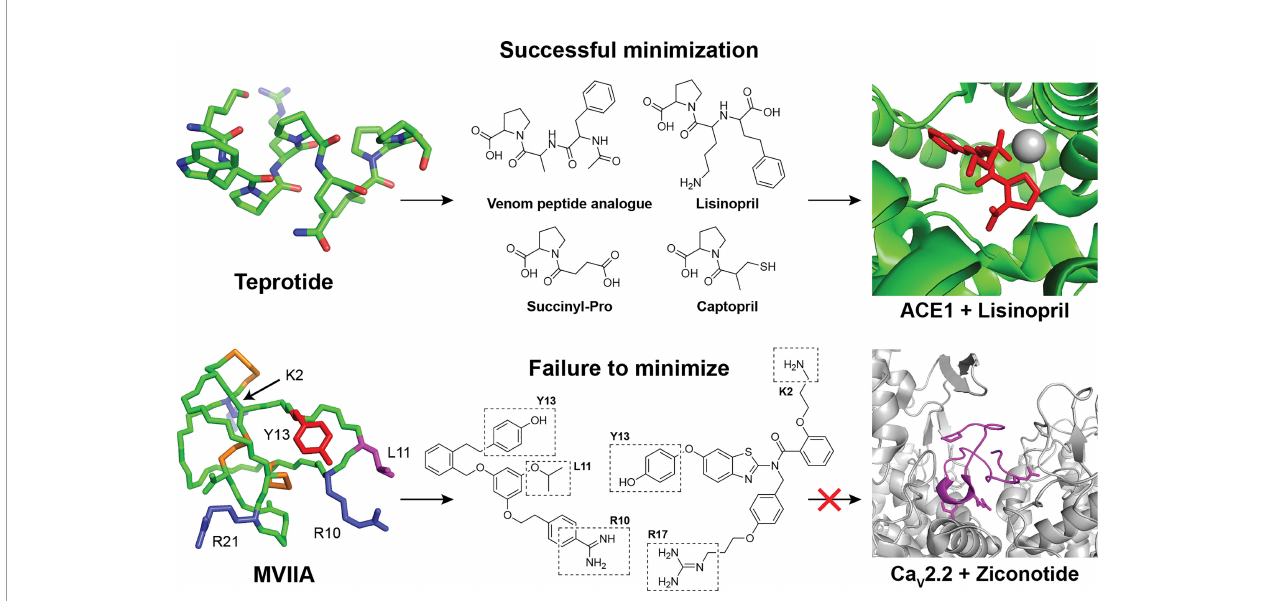
FIGURE 1 | Examples of successful and unsuccessful attempts to minimize natural peptide leads during drug development. Top row: The natural teprotide peptide from the snake Bothrops jararaca is a potent inhibitor of the angiotensin-1-converting enzyme (ACE-1) (7). The native nonapeptide can be effectively truncated and modi fi ed to yield a range of simpli fi ed and optimized analogs with optimal binding to ACE-1[PDB: 1J36 (8)] (9). Bottom row: The highly complex and bioactive MVIIA peptide [PDB: 1TTK (10)] from the marine snail Conus magus have therapeutic value in the treatment of neuropathic pain by inhibiting N-type (Ca v 2.2) voltage-gated calcium channels [PDB: 7VFW (11)] (12). Despite extensive analog development and minimization efforts, no improved leads have been reported and the fi nal marketed drug Ziconotide is identical to the native venom peptide